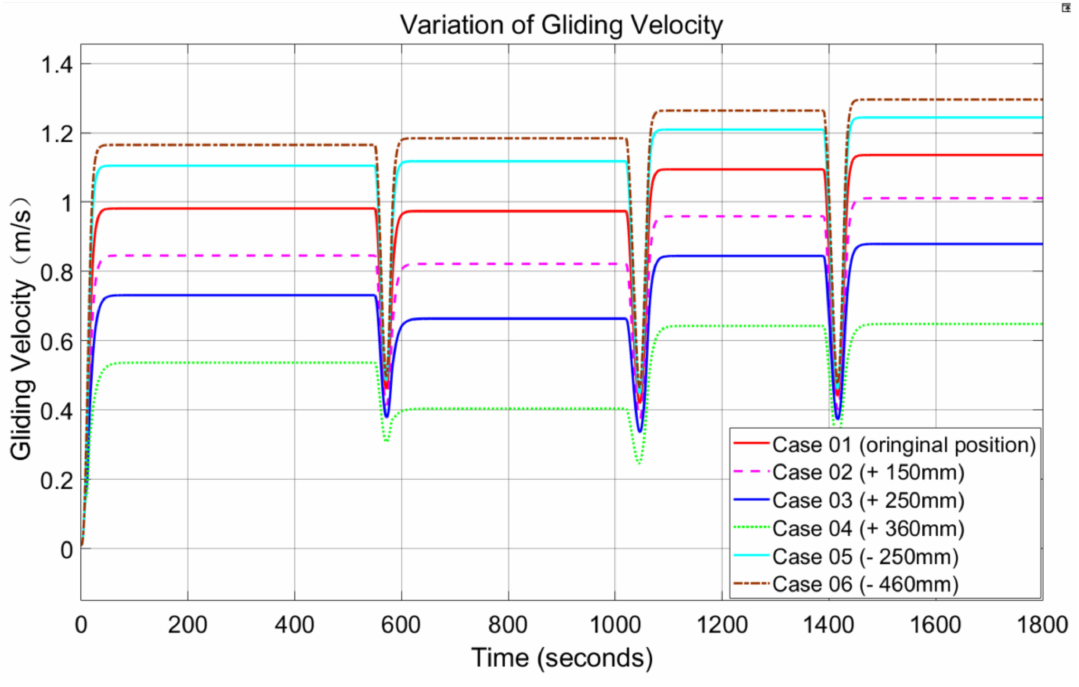
Figure 13. Simulation results of the gliding velocity.